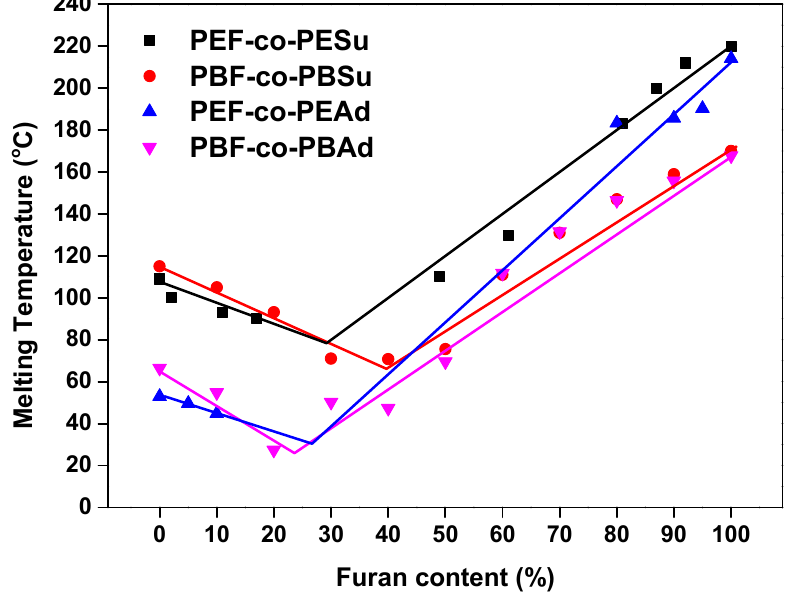
Figure 8. Eutectic behavior of alipharomatic copolymers [50,52,73,79]. The lines are just to guide the eye.